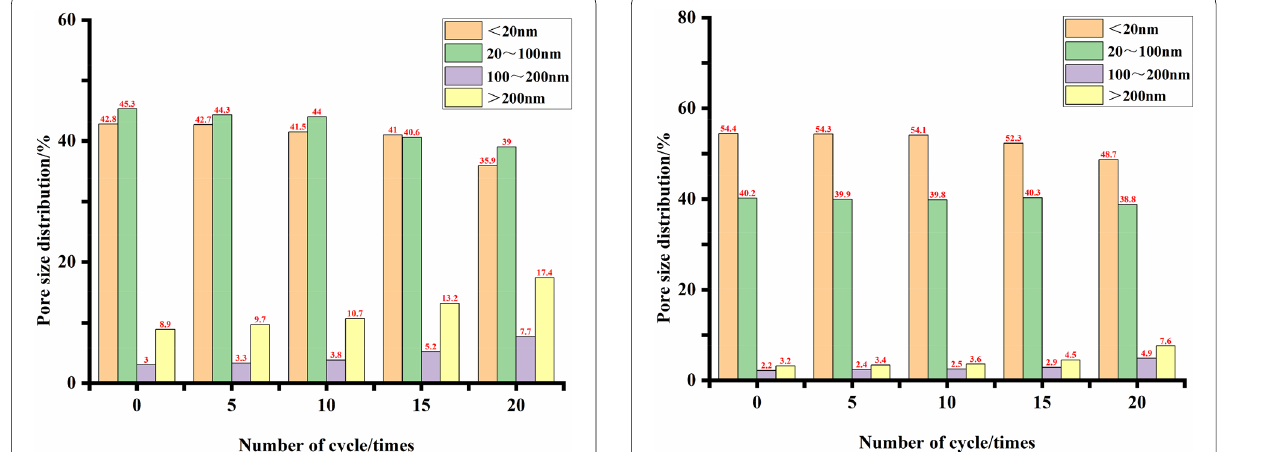
Fig. 12 The pore size distribution of concrete at different single-side salt-freezing–drying–wetting cycles (C).